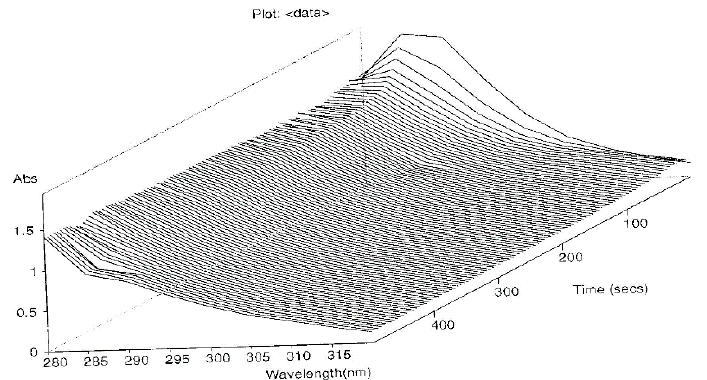
Figure 5. Time-resolved spectra (many spectra are obtained in the 280–320-nm range per shot with the 0.15-s interval) of 5.00 × 10 − 3 M of each compound mixed together in ethanol at 20 °C.